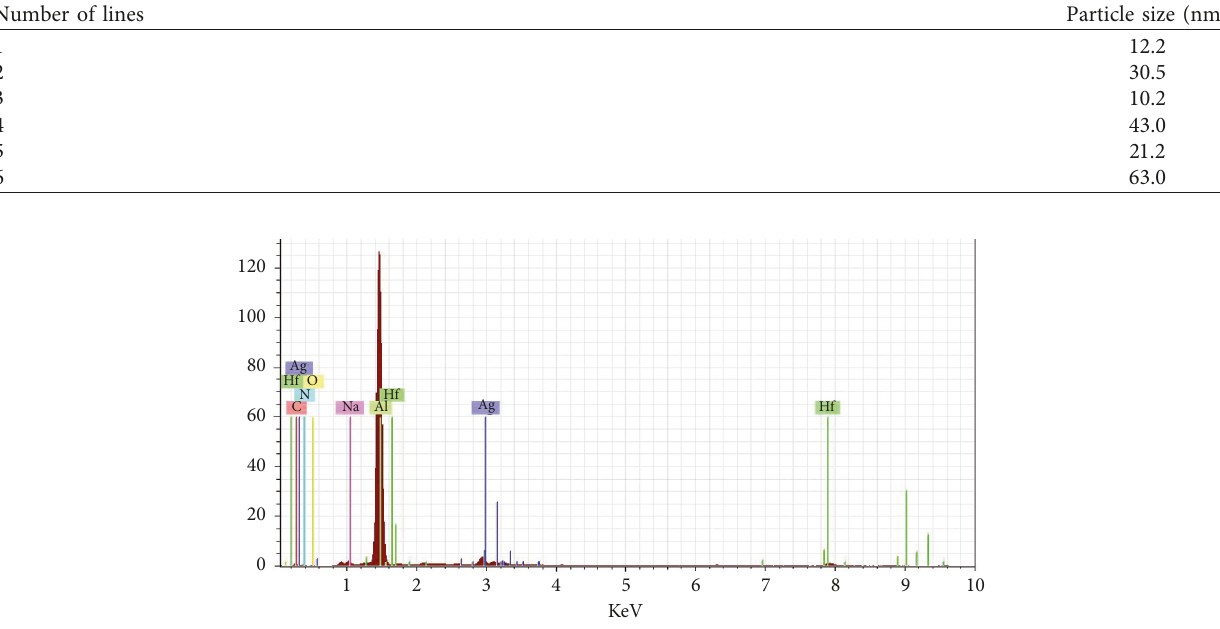
Figure 7: EDX analysis of green-synthesized AgNPs by Malva parviflora leaves extract.